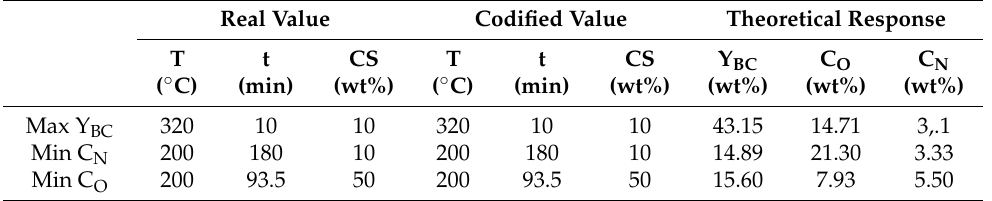
Table 3. Theoretical values to maximise the biocrude yield and minimise de N and O